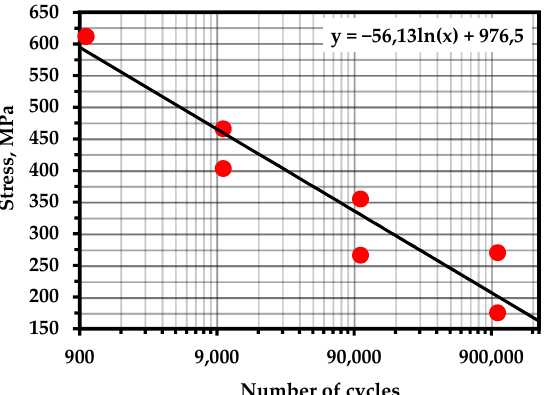
Figure A12. S–N Curve—Steel C55 (accepted as an analogue) (Temperature—293 K; frequency—30 Hz) [105].